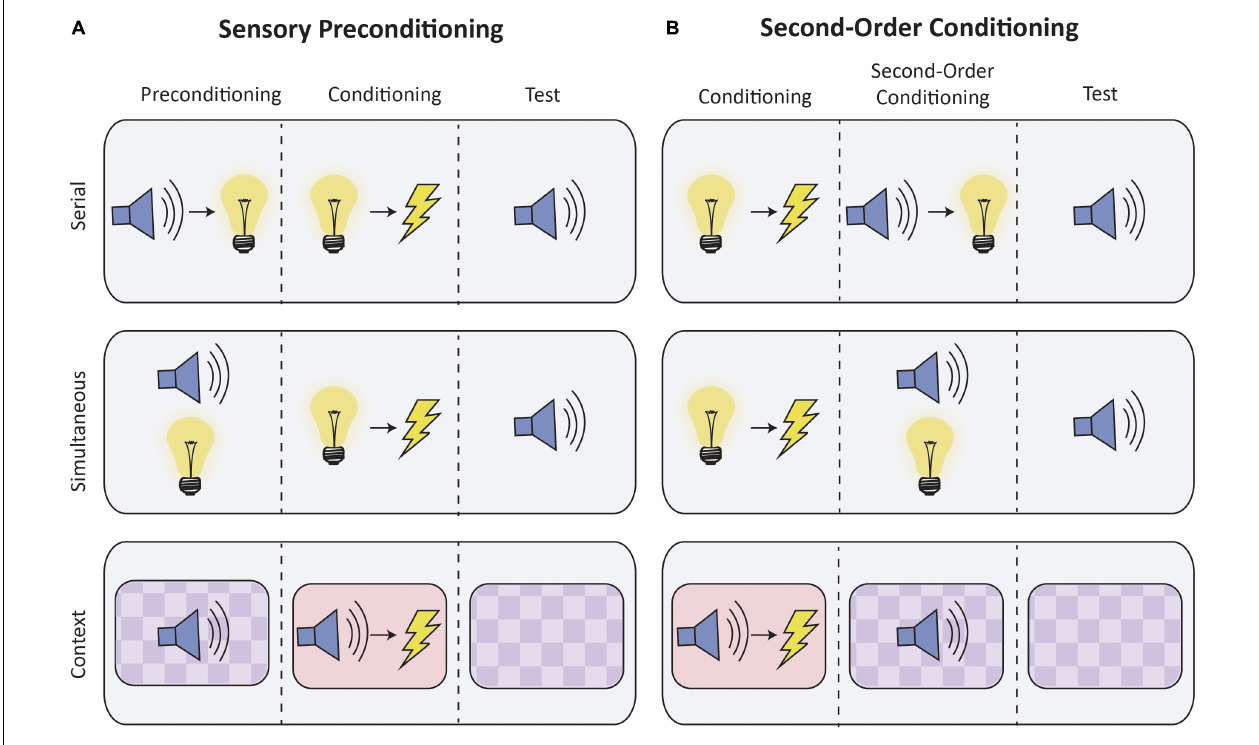
FIGURE 1 | Schematic of higher-order conditioning procedures. The figure depicts typical experimental conditioning for sensory preconditioning (A) and second-order conditioning (B) , which are contrasted with control conditions (not shown). Discrete stimuli can be presented either serially (top row) or simultaneously (middle row). Higher-order conditioning of contextual stimuli is presented in the bottom row. Contexts are operationally defined as the static background stimuli provided by conditioning apparatus, and typically differ with respect to visual, tactile and olfactory characteristics. In the figure, contexts are distinguished by color and